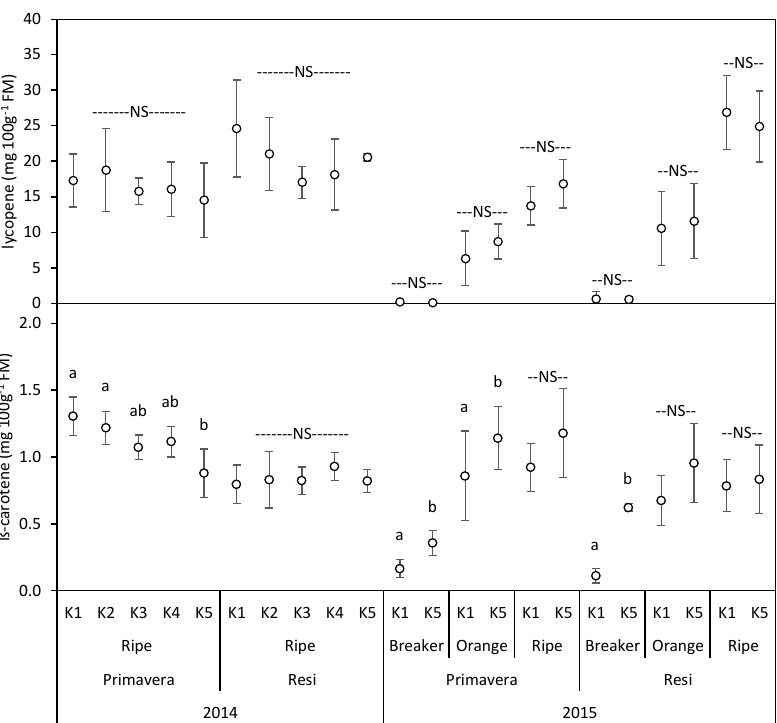
Fig. 3: Potassium (K) fertilization differentially affects the carotenoids lycopene and β-carotene in the cultivars. Mean values and standard deviations were determined from four biological replicates. K levels increased from K1 to K5 (0.37 g, 0.73 g, 1.47 g, 2.2 g, and 3.66 g K 2 SO 4 per week) for each cultivar. Letters indicate statistically significant differences and NS indicates no significant difference, according to a Mann-Whitney-U or Tukey-HSD test. Tab. 3: Potassium (K) fertilization differentially affects the tocopherols (α, β, γ, δ).